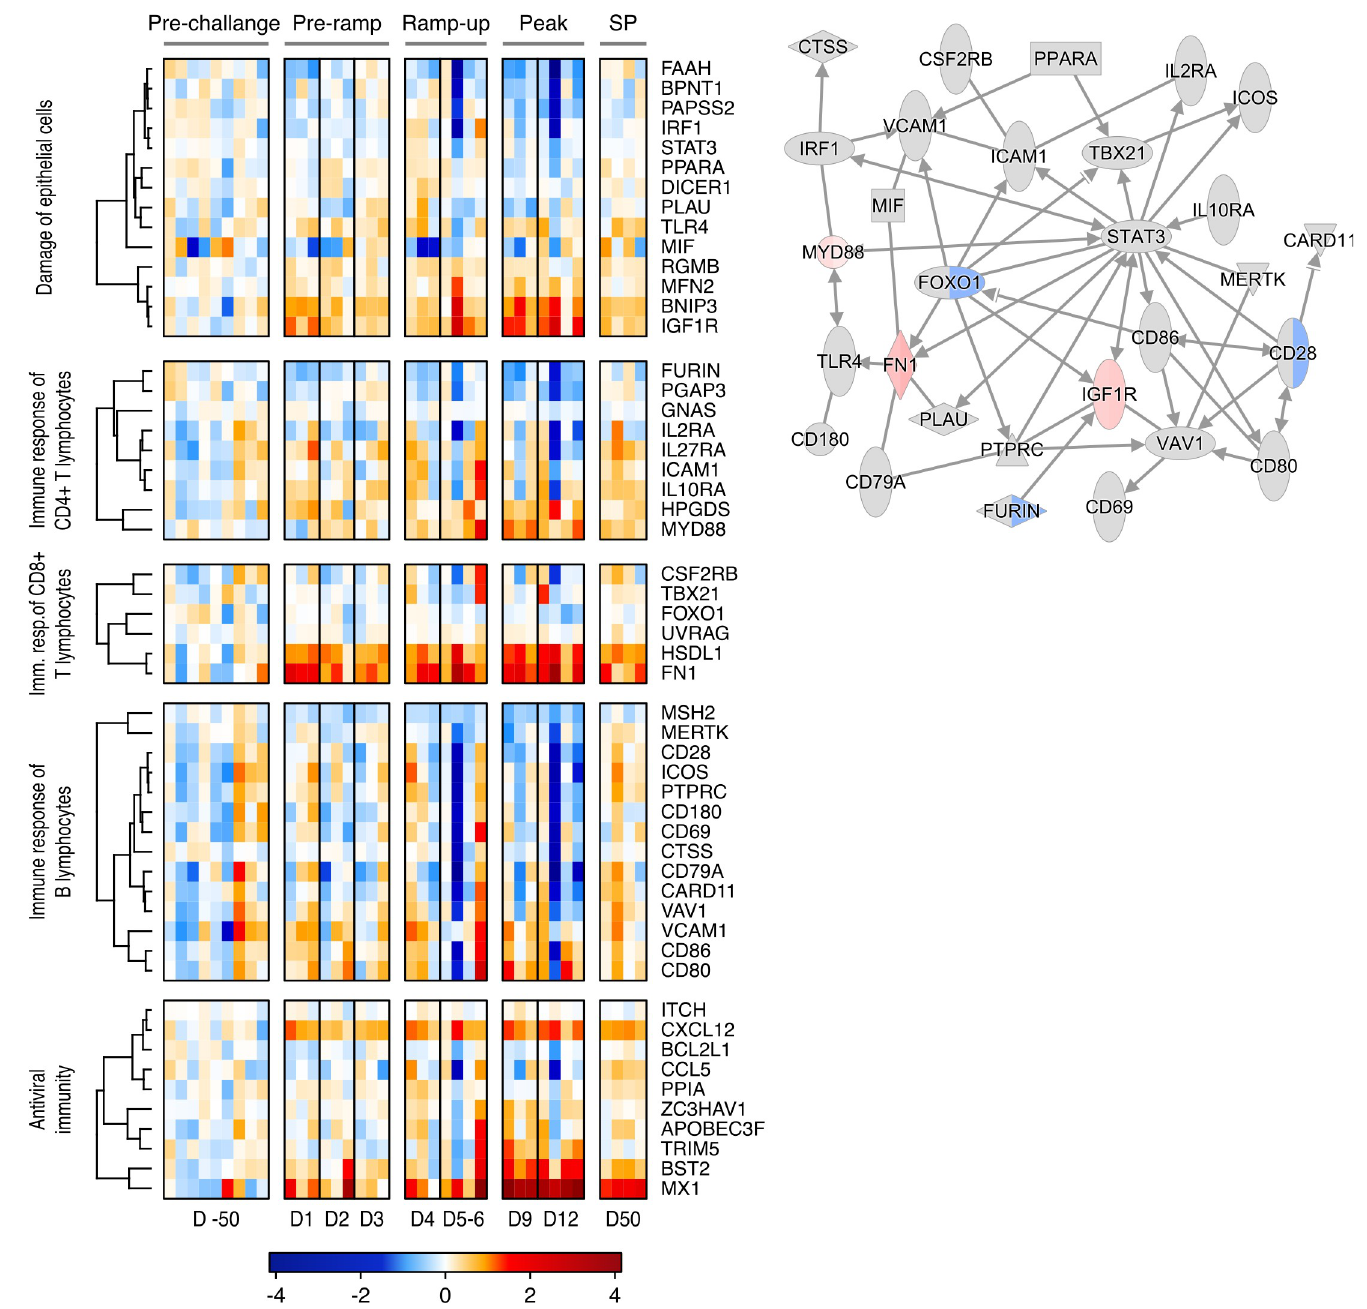
Fig 9. Heatmap & network of gene expression in the gut during SIV infection in AGMs. RNAseq data from AGM gut tissue displayed as (A) a heatmap showing gene expression changes in genes associated with biological processes related to SIVsab infection, immune responses and damage to the gut epithelium. Here, pre- challenge represents the changes in gene expression between each of the individual animals preinfection versus the average changes for the entire pre-challenge group in order to show natural genetic variation. The changes in pre-ramp (1–3 dpi), ramp-up (4–6 dpi), peak (9–12 dpi) and set-point (SP, 46–55 dpi) groups represent the change in gene expression post-infection for each animal compared to the pre-challenge group averages. (B) a network showing direct interactions between genes in SIV related processes at the peak of infection (9–12 dpi). For the heatmap, the level of alteration of gene expression is shown in blue (downregulation) and red (upregulation), with genes clustered using a Spearman correlation, with the dendrogram showing relationship displayed on the left. For the pathway, each gene is shown as a node and the arrows between nodes indicate direct gene interactions. Red nodes indicate upregulation of gene expression, green nodes indicate downregulation. In split nodes, the left and right node sections correspond to 9 dpi and 12 dpi, respectively.